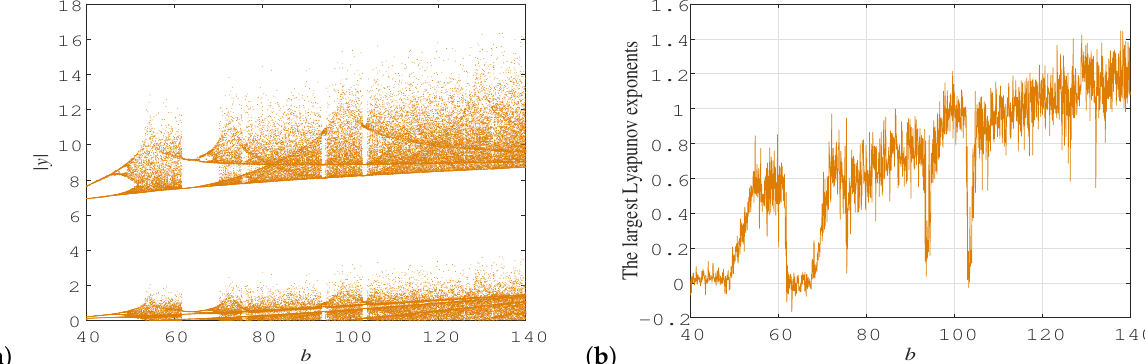
Figure 6. Two-dimensional views of coexisting chaotic attractors and periodic attractors in system (2) with parameters b = 100, c = 10, and k = 4.6 : ( a ) a = 27.35, ( x 0 , y 0 , z 0 ) = ( 1,1,1 ) , ( b ) a = 27.35,